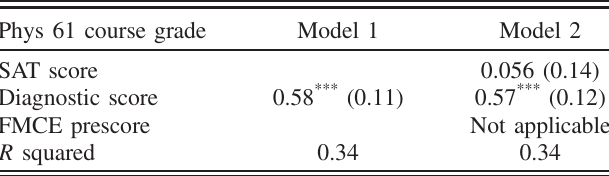
TABLE II. Regression of Phys 61 course grades on measures of incoming preparation. *** p < 0 . 001 .